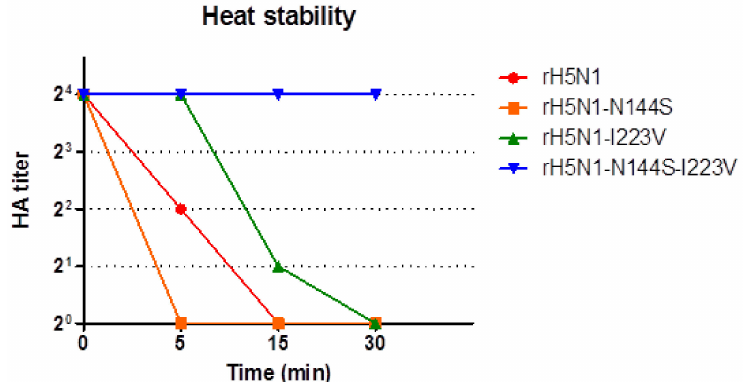
Figure 4. Heat stability of recombinant H5N1 viruses. Each of the recombinant viruses was diluted to a 2 4 HA titer, and aliquots were incubated at 60 ◦ C for 0, 5, 15, and 30 min. After heat treatment, the HA titer of each aliquot was measured by HA assay with 1% chicken